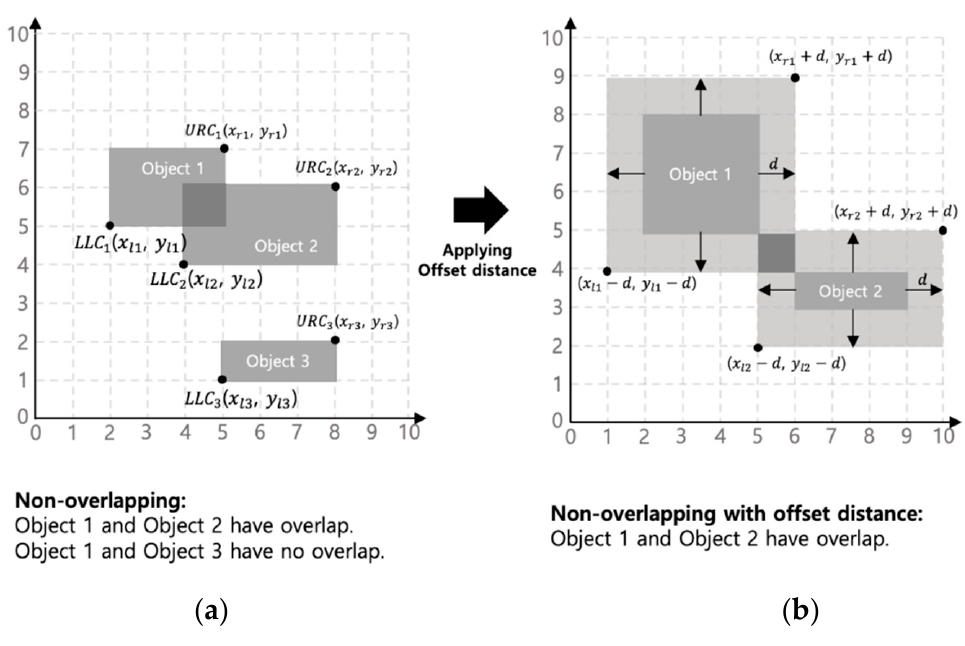
Figure 6. Non-overlap constraint: ( a ) non-overlapping and ( b ) non-overlapping with offset con- straints.